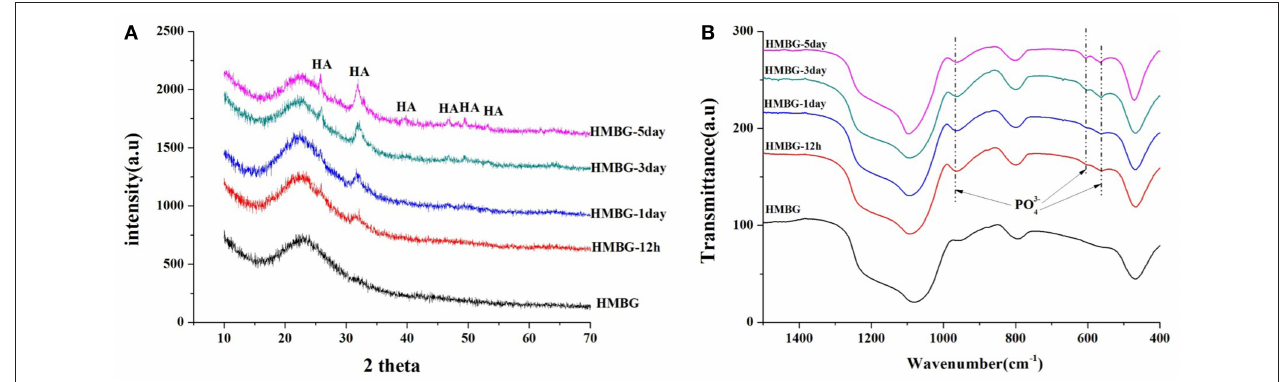
FIGURE 6 | XRD patterns (A) and FT-IR spectra (B) of HMBG after soaking in SBF for different times.